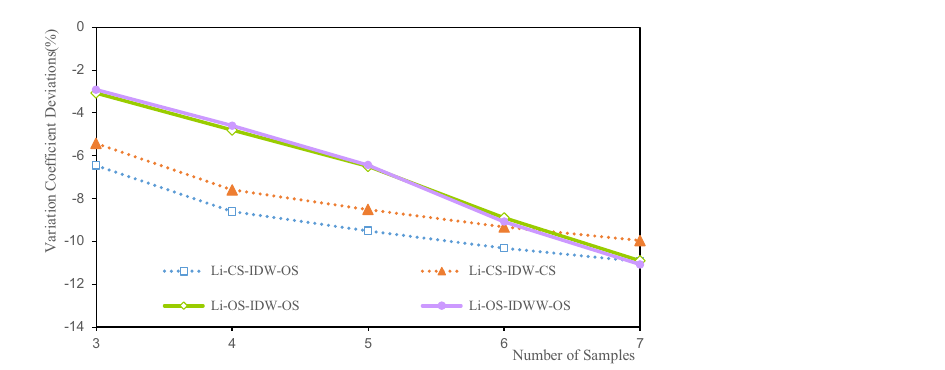
Figure 12. Deviation of the variation coefficient of the Li